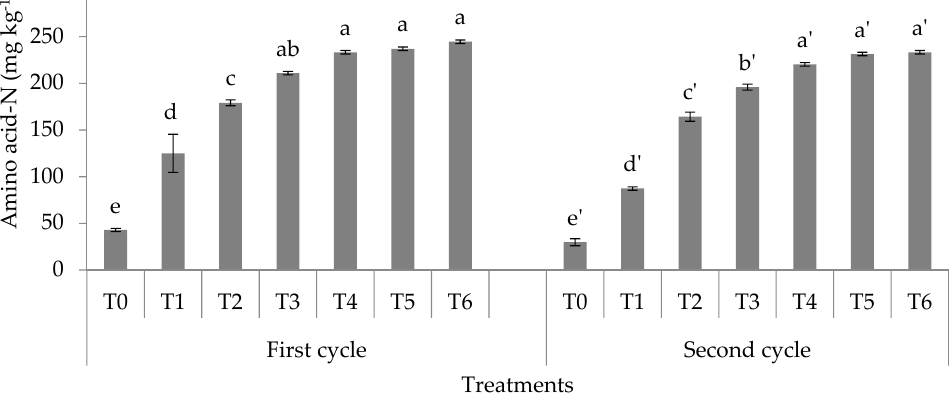
Figure 6. Effects of treatments on soil amino acid-nitrogen. Means with the same letter above the bars within a crop cycle are not significantly different at p ≤ 0.05. Bars represent the mean values ± standard error .